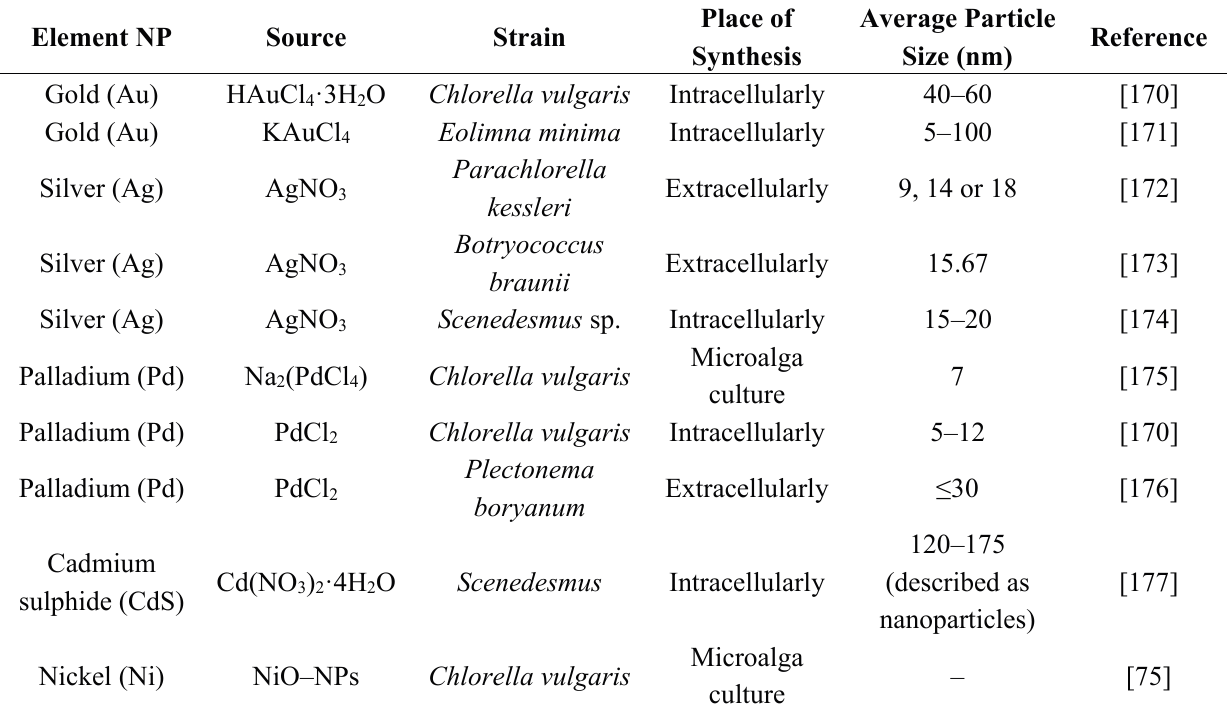
Table 4. Synthesis of nanoparticles (NP) in microalgae and cyanobacteria cultures. Element